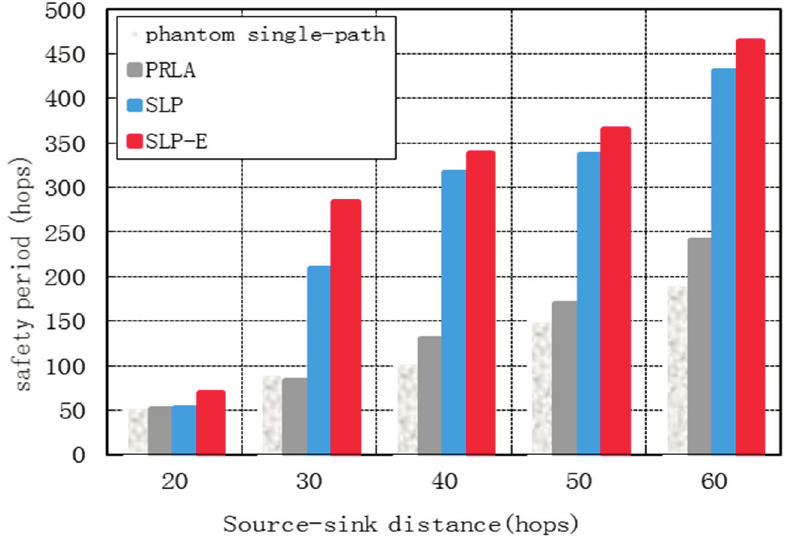
Figure 7. Safety period vs. source-sink distance